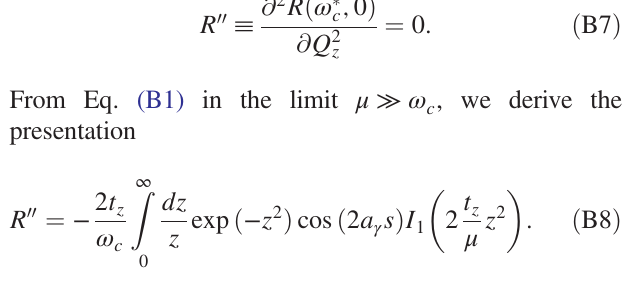
FIG. 8. The dependence of the critical Maki ’ s parameter α μ =t FIG. 7. The dependence H on Q for single-band layered . Note that at negative μ this parameter approaches the known C 2 z z superconductor with different γ . The parameters that are used in value for the isotropic case α z = μ ¼ 0 . 3 . For γ < γ C the plot are t , the maximum H is always z z z C 2 0 . If γ > γ C at Q , the maximum H moves to finite Q z z ¼ z C 2 z